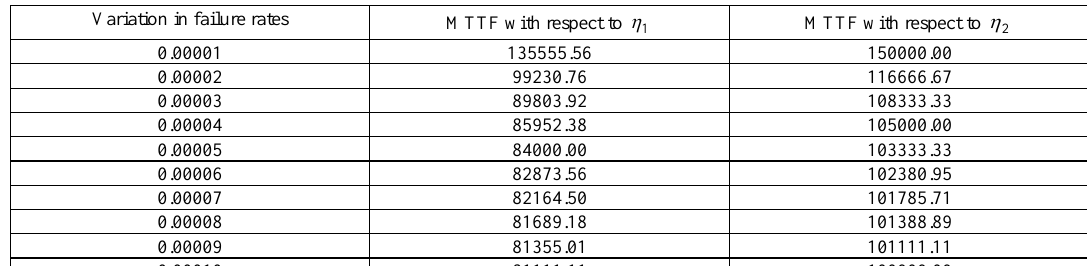
Table 5. MTTF of the system.